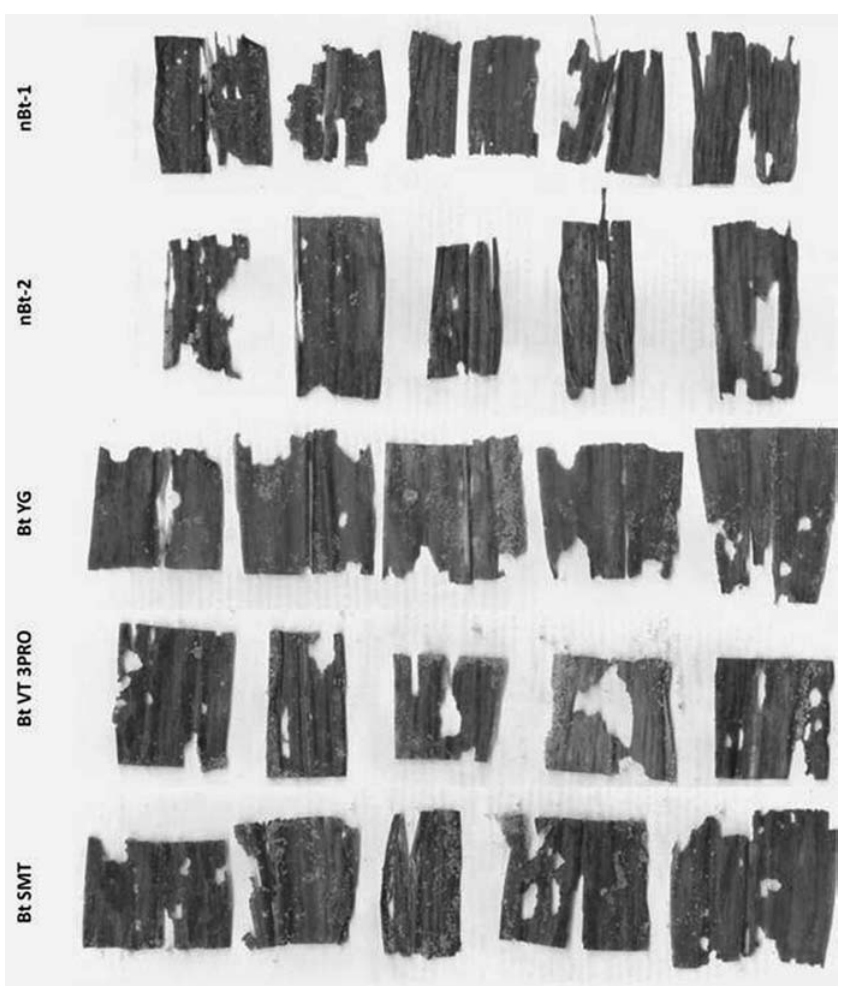
Fig. 2. Consumption pattern of Coptotermes formosanus feeding onnon-Bt (on nonBt-1, and Bt maize